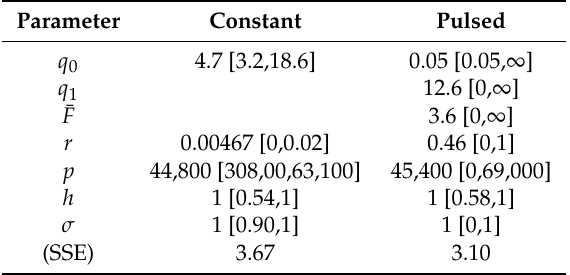
Table 5. Fitted parameters for the Saenz et al. dataset under constant and pulsed secretion rate models. Confidence intervals are at the 95% level. IFN and viral units are in units of